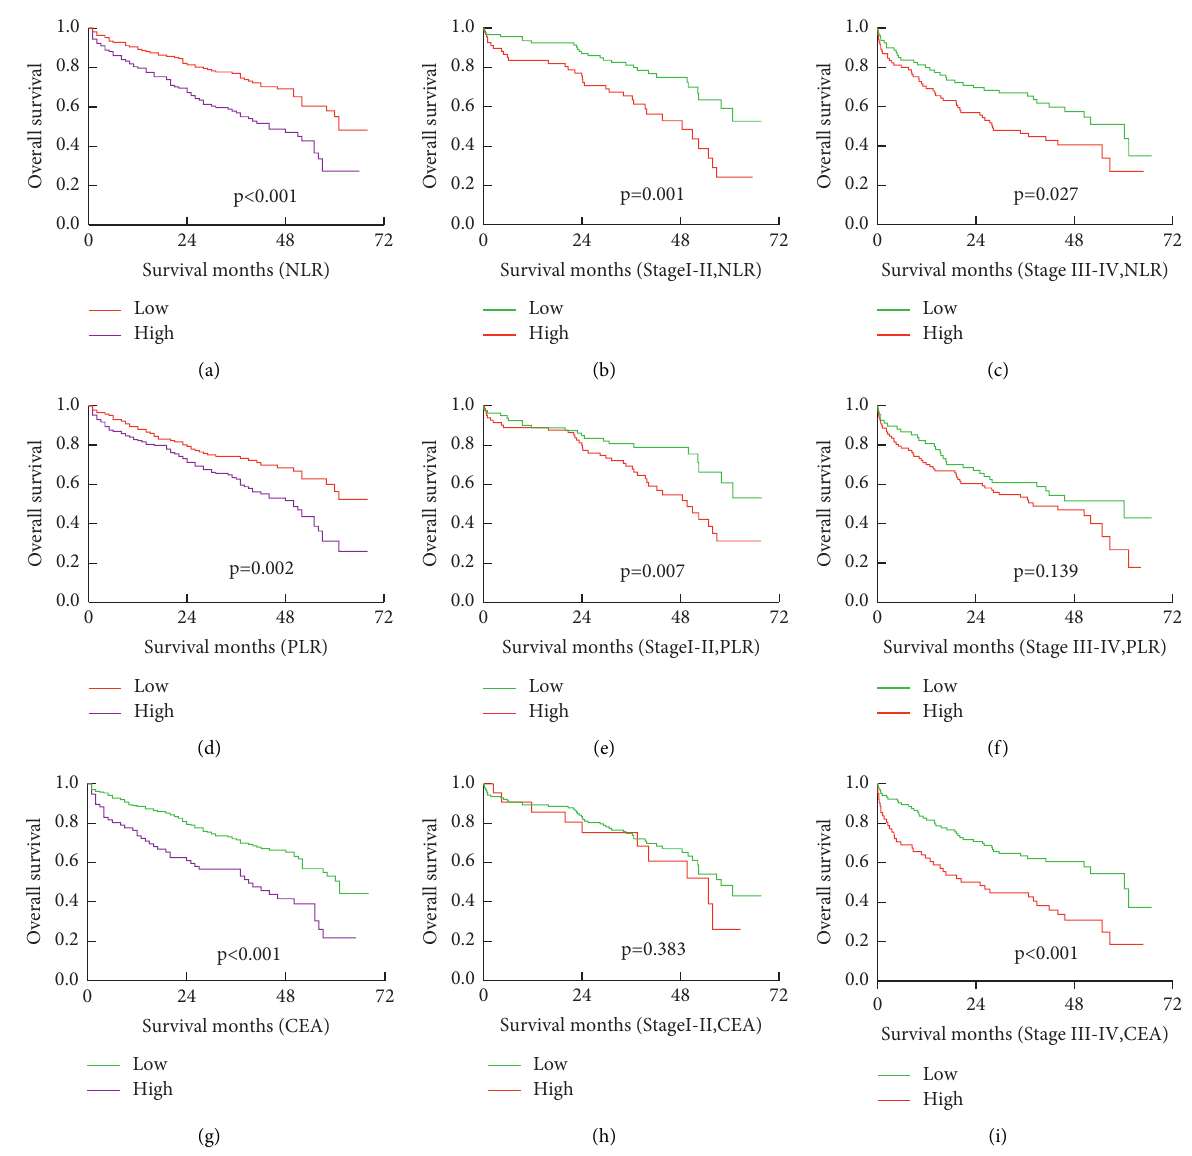
Figure 2: Kaplan–Meier estimates of overall survival (OS) according to the NLR, PLR, and CEA.:(a) according to NLR ( P < 0 . 001), (b) according to NLR in stage I-II ( P � 0 . 001), (c) according to NLR in stage III-IV ( P � 0 . 027), (d) according to PLR ( P � 0 . 002), (e) according to PLR in stage I-II ( P � 0 . 007), (f) according to PLR in stage III-IV ( P � 0 . 139), (g) according to CEA ( P < 0 . 001), (h) according to CEA in stage I-II ( P � 0 . 383), (i) according to NLR in stage III-IV ( P < 0 .